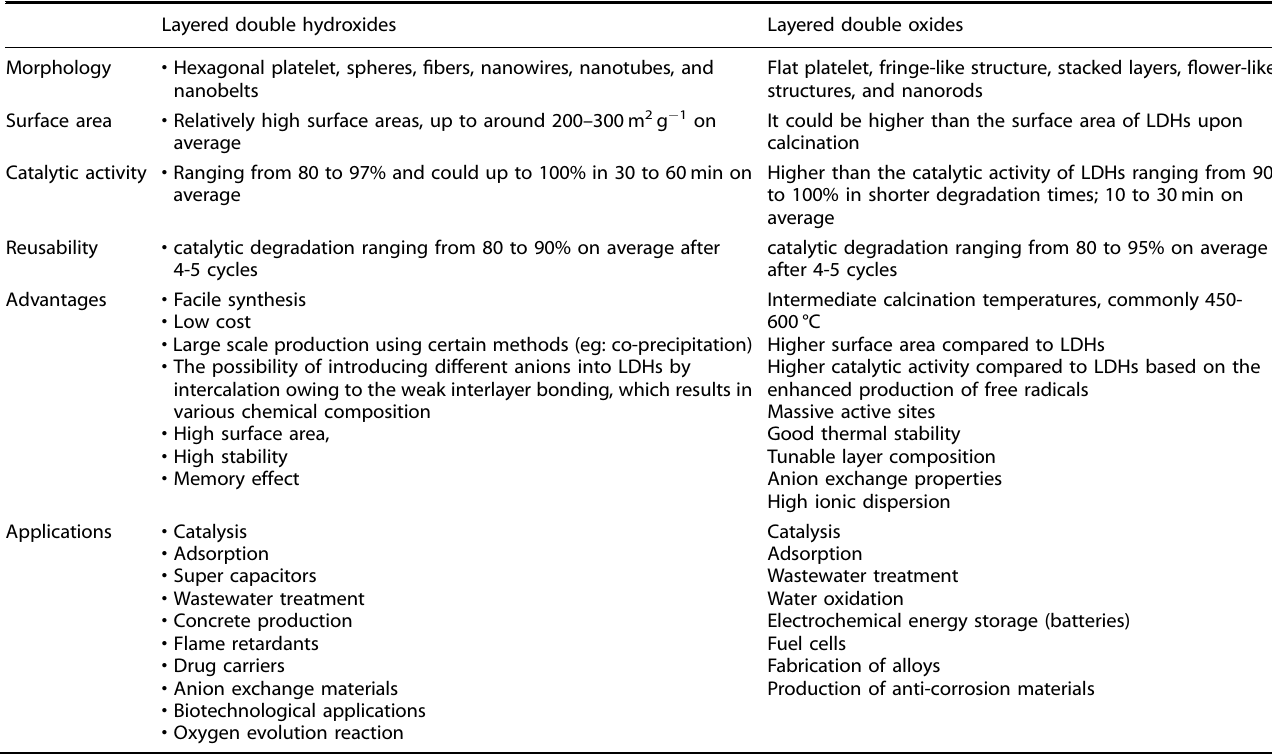
Table 1. A comparison between the main characteristics of LDHs and LDOs. Layered double hydroxides Layered double oxides Morphology Surface